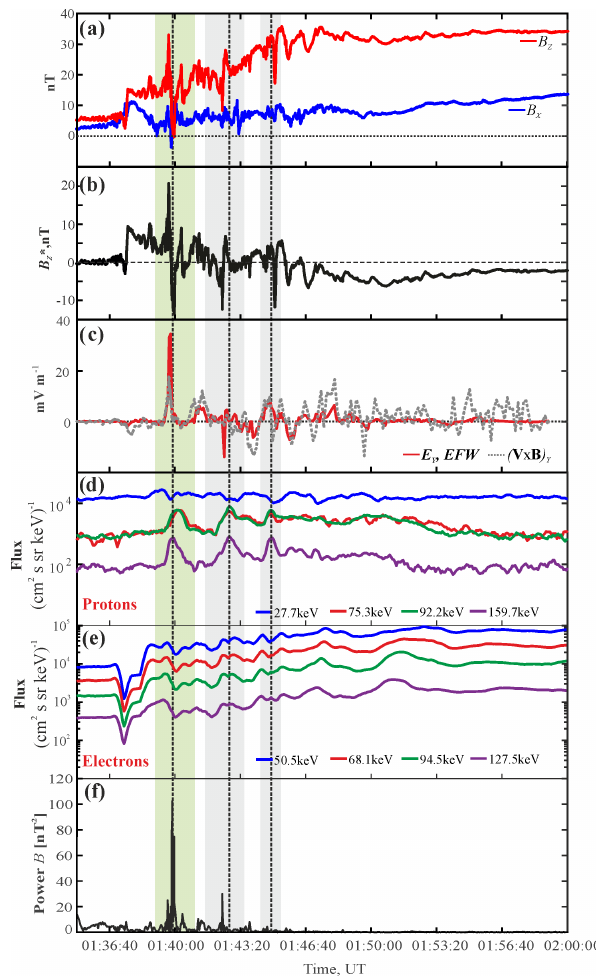
Figure 5. From top to bottom the following data observed by C4 spacecraft are shown: the time profiles of B X and B Z components (a) ; the time profile of B Z * ( b ; see explanations in the text), the dawn–dusk electric field (c) , proton fluxes in several energy chan- nels (d) , fluxes of suprathermal electrons for the reference (e) and the time profile of the power of magnetic field fluctuations at proton gyrofrequency (f) . The interval of the dispersed proton injection is shaded light yellow and the intervals of dispersionless injections are shaded grey. The moments of peak proton flux in each injection are shown by vertical dashed